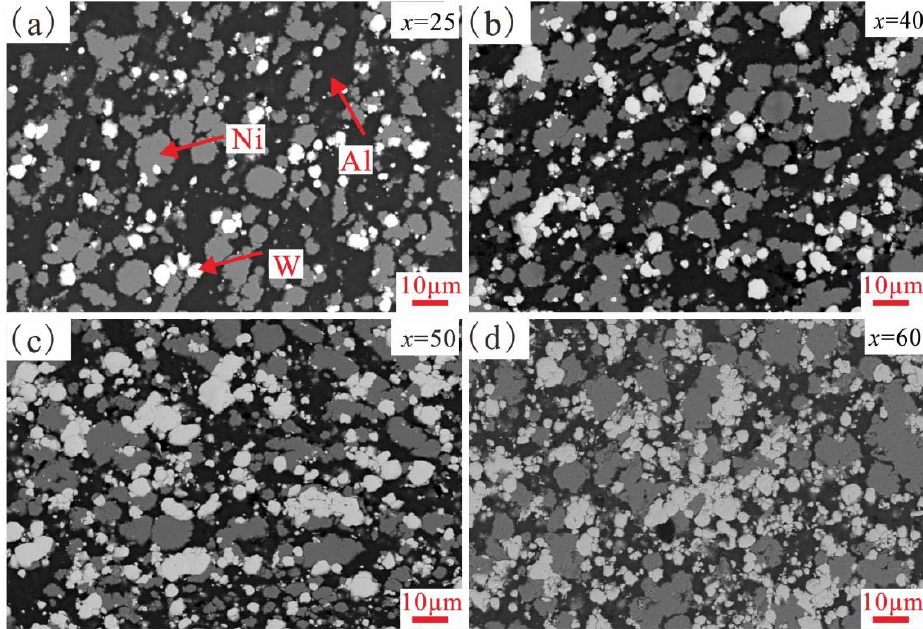
Figure 1. BSE images of the hot-pressed (48Al–52Ni) 100- x W x composites. ( a ) x = 25; ( b ) x = 40; ( c ) x = 50; ( d ) x = 60.